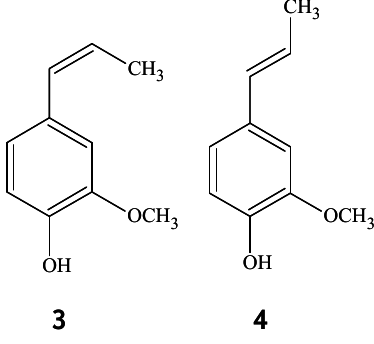
Figure 1. Isoeugenol: 2-methoxy-4-[( Z )-1-propenyl] phenol ( 3 ) and 2-methoxy-4-[( E )-1- propenyl] phenol ( 4 ).